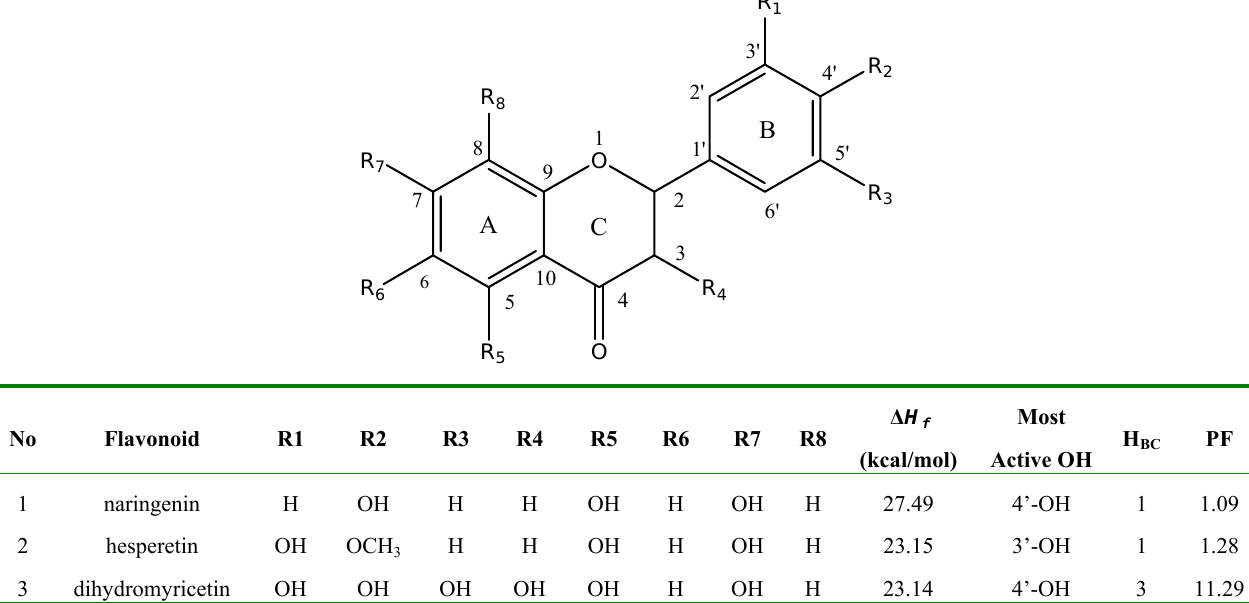
Table 2. Chemical structures, descriptors and antioxidant activity of some flavanones and flavanonols